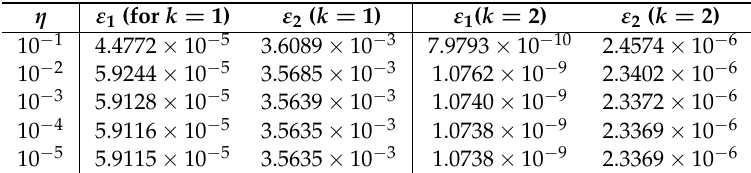
Table 1. ε 1 together with their corresponding upper bounds ε 2 of Example